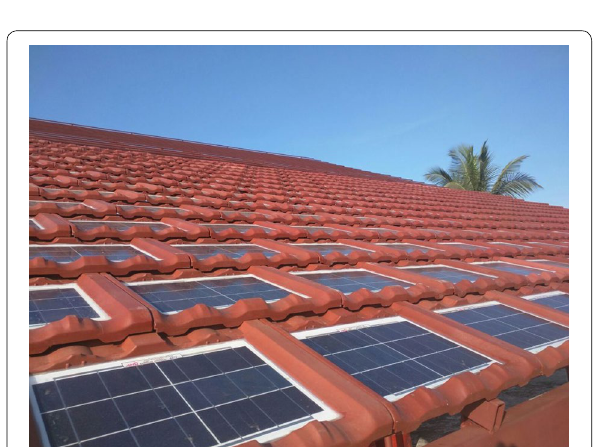
Fig. 10 Photovoltaic tile (from http://anuso lar.com) Fig. 11 Photovoltaic plant of medium size (Library roof plant of Politecnico of Milano. Picture by